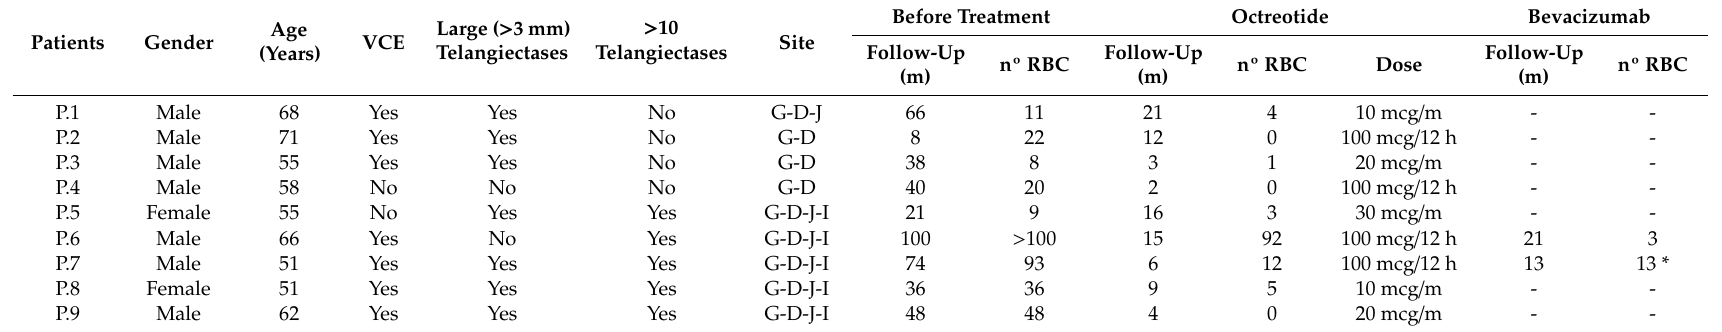
Table 5. Evolution of patients with gastrointestinal involvement treated with octreotide and